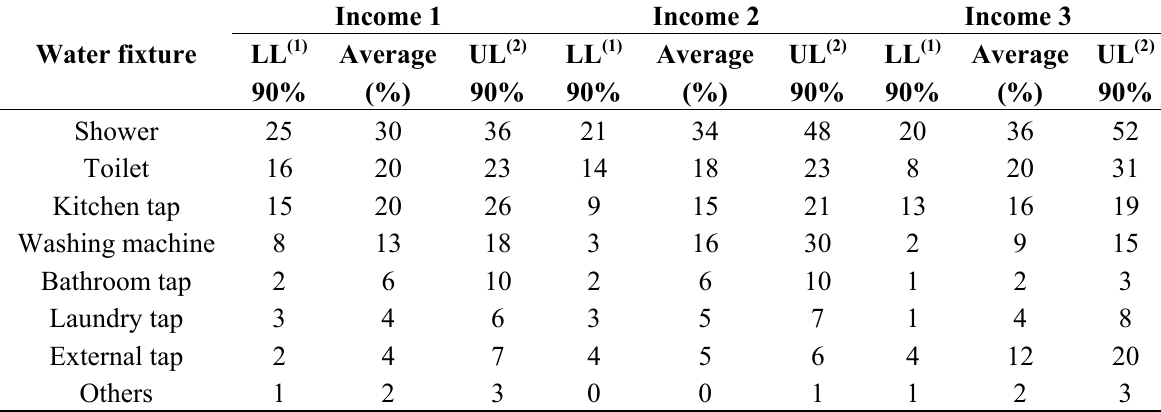
Table 6. Average percentage water end-uses and lower and upper limits for 90%